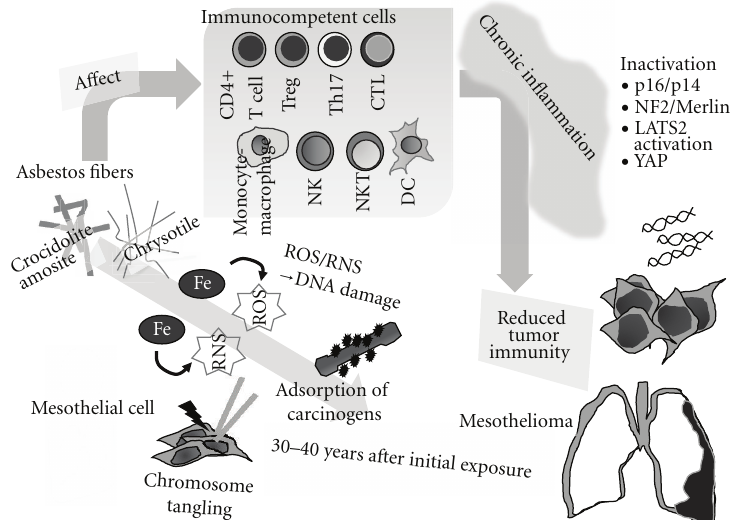
Figure 3: Schematic model showing mechanisms of asbestos-induced carcinogenesis and genomic/epigenetic changes found in mesothe- lioma cells, carcinogenic activities of asbestos fibers, and the relationship of the immunological e ff ects of asbestos in regard to chronic in-flammation and reduced tumor